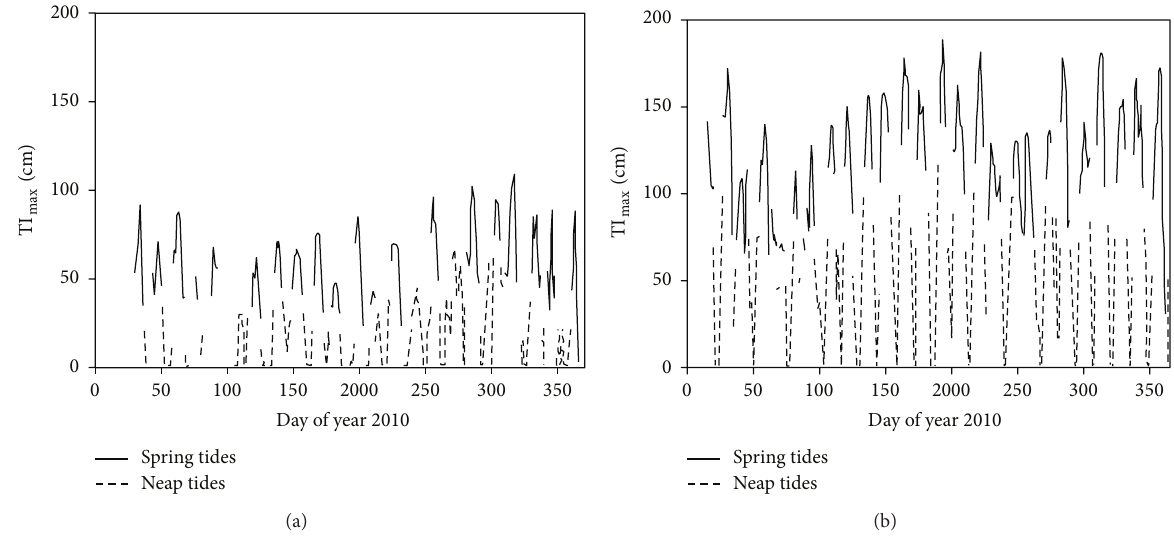
Figure 3: The differentiation of spring and neap tide periods of the two mangrove forest sites ((a) FJZZ and (b) GDZJ) in 2010 based on the daily maximum value of tidal inundation depth (TI max